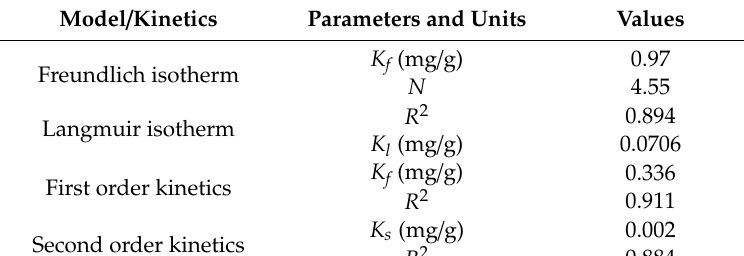
Table 4. Model terms and constants for: Freundlich and Langmuir isotherms, first and second order kinetic equations.